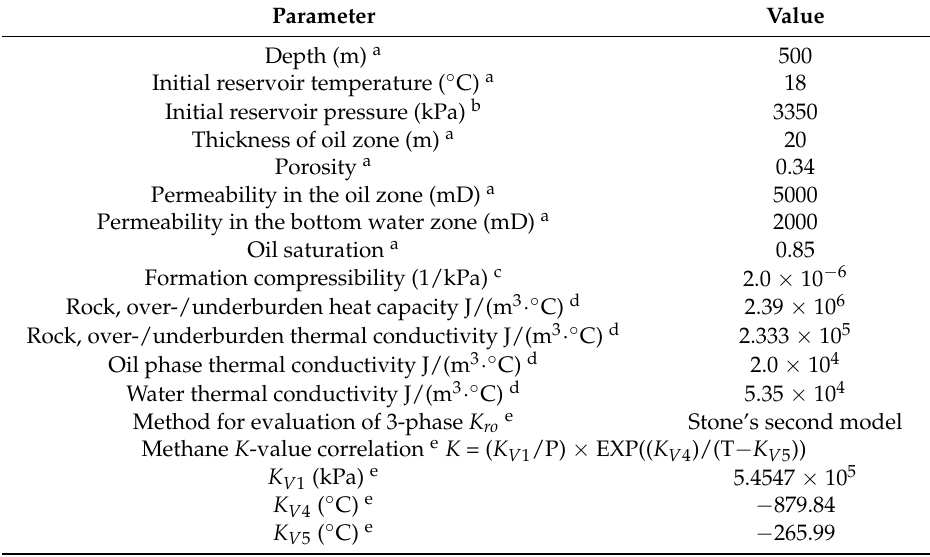
Table 1. Properties of the reservoir in the Pikes Peak oil field, Lloydminster region. Parameter Value Depth (m) a 500 Initial reservoir temperature ( ◦ C) a 18 Initial reservoir pressure (kPa) b 3350 Thickness of oil zone (m) a 20 Porosity a 0.34 Permeability in the oil zone (mD) a 5000 Permeability in the bottom water zone (mD) a 2000 Oil saturation a 0.85 Formation compressibility (1/kPa) c 2.0 × 10 − 6 Rock, over-/underburden heat capacity J/(m 3 · ◦ C) d 2.39 × 10 6 Rock, over-/underburden thermal conductivity J/(m 3 · ◦ C) d 2.333 × 10 5